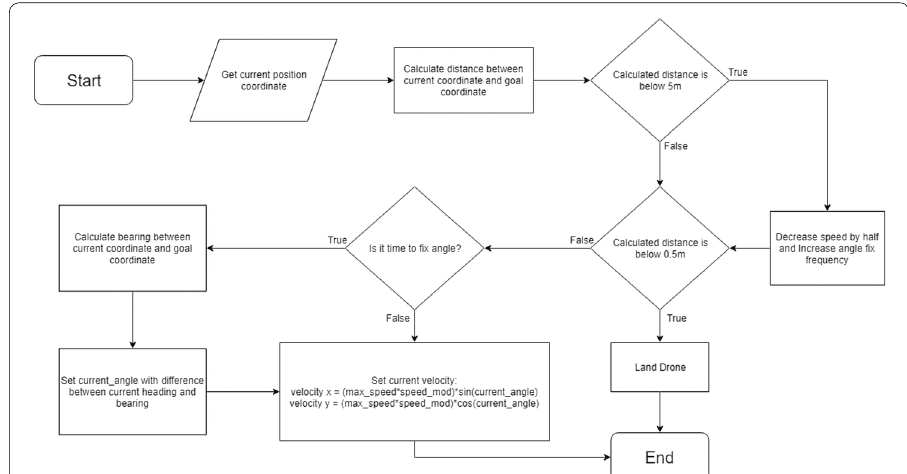
Fig. 7 Navigation without course-over-ground algorithm